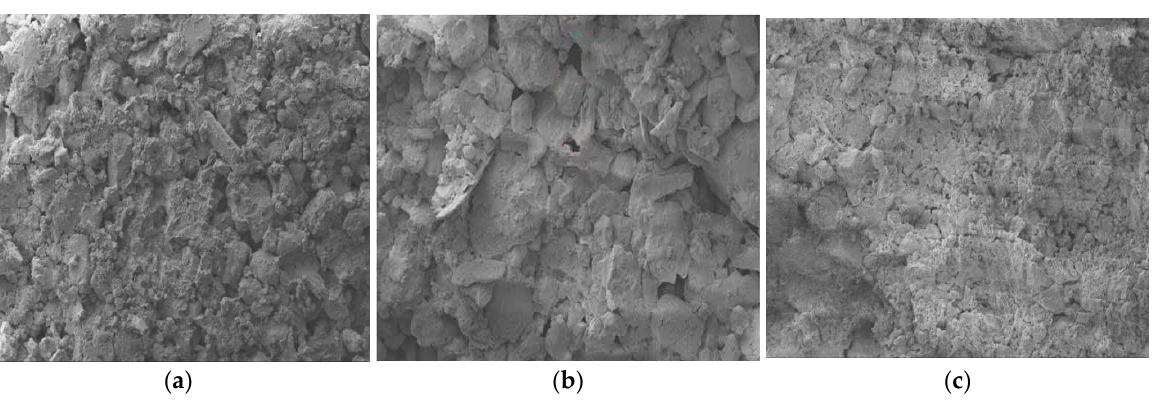
Figure 3. Layered modeling diagram.